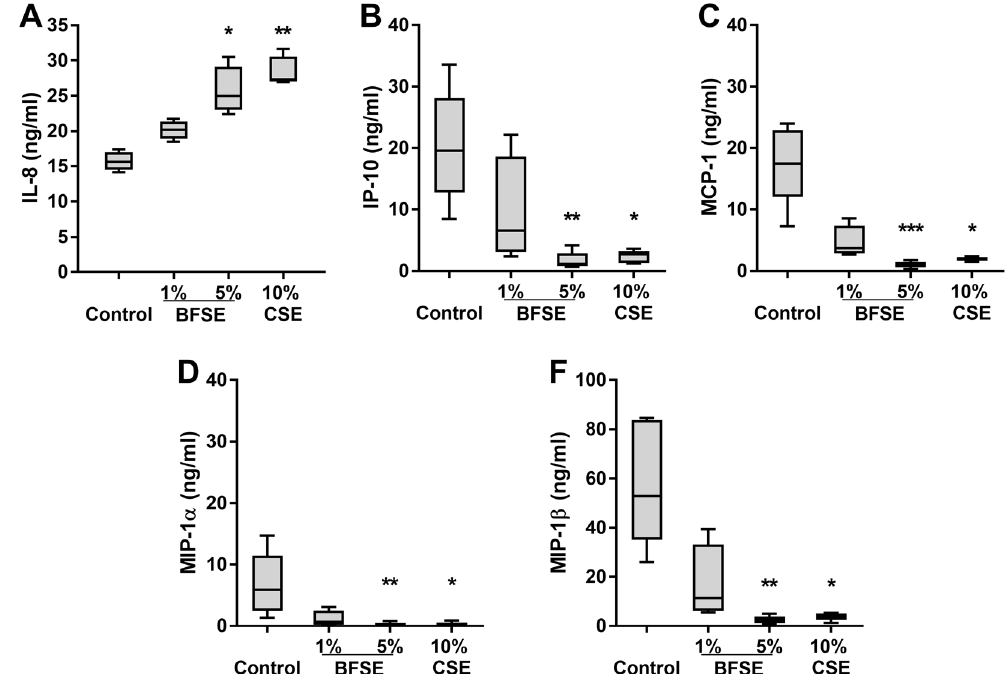
Figure 4. BFSE alters THP-1 macrophage chemokine secretion. THP-1 macrophage cells were exposure to air control or 1% or 5% BFSE or 10% CSE for 24 h. Supernatants were collected and assessed for IL-8 ( A ), IP-10 ( B ), MCP-1 ( C ), MIP-1 α ( D ) and MIP-1 β ( F ) by chemokine bead array and analysed by flow cytometry (n = 5). * p < 0.05 ** p < 0.01 *** p <